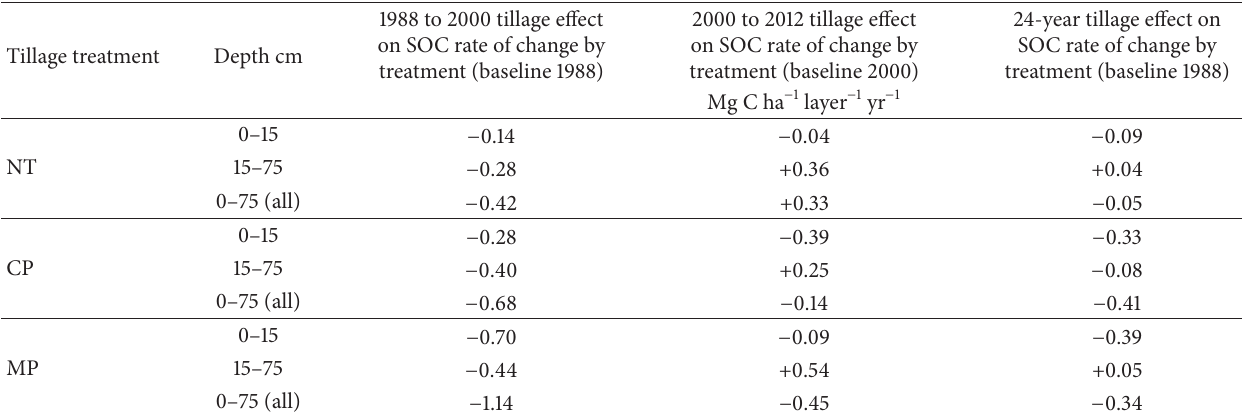
Table 8: Use of pretreatment SOC baseline (1988) to determine the rate of SOC change During the first 12 years and for 24 years of tillage. A 2000 baseline was used for the last 12 years on the volumetric SOC content (Mg C ha − 1 layer − 1 yr − 1 ) of the Grantsburg